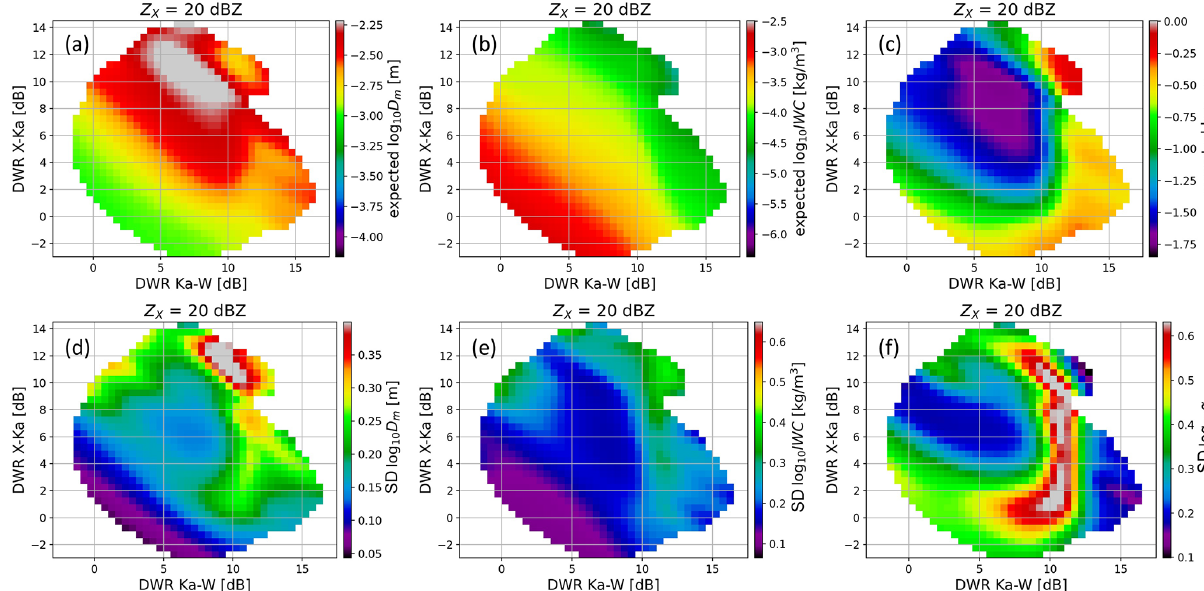
Figure 2. (a–c) The expected values of log 10 D m , log 10 IWC and log 10 α rm in the DWR X − Ka –DWR Ka − W space for Z X = 20dBZ. (d– f) Uncertainties in the quantities presented in the top row (see the colour bar captions). The inverse model is derived from the in situ airborne PSD measurements during the MC3E, IPHEx, OLYMPEX and HAIC/HIWC